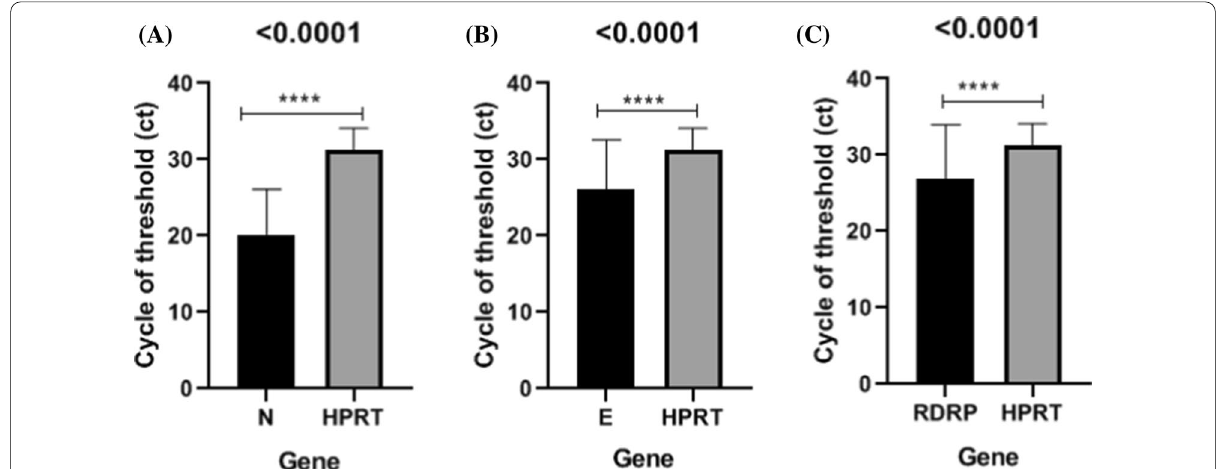
Fig. 2 Cycle threshold (Ct) value of qRT‑PCR. HPRT gene was used as an internal control. A Comparison of N target and HPRT, B Comparison of E target and HPRT, and C Comparison of RDRP target and HPRT. A significant difference is indicated by *P < 0.05. ****